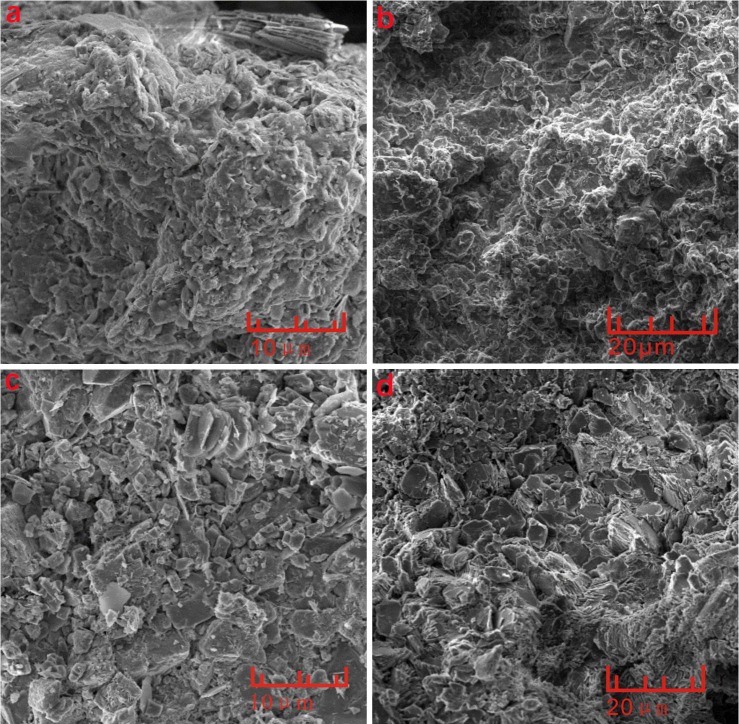
SEM photomicrographs of rock sample surfaces from Hudiedong Cave.(a) HDD-1, (b) HDD-2, (c) HDD-3, and (d) HDD-4. Fig 7 is excluded from this article's CC-BY license. See the accompanying retraction notice for more information.